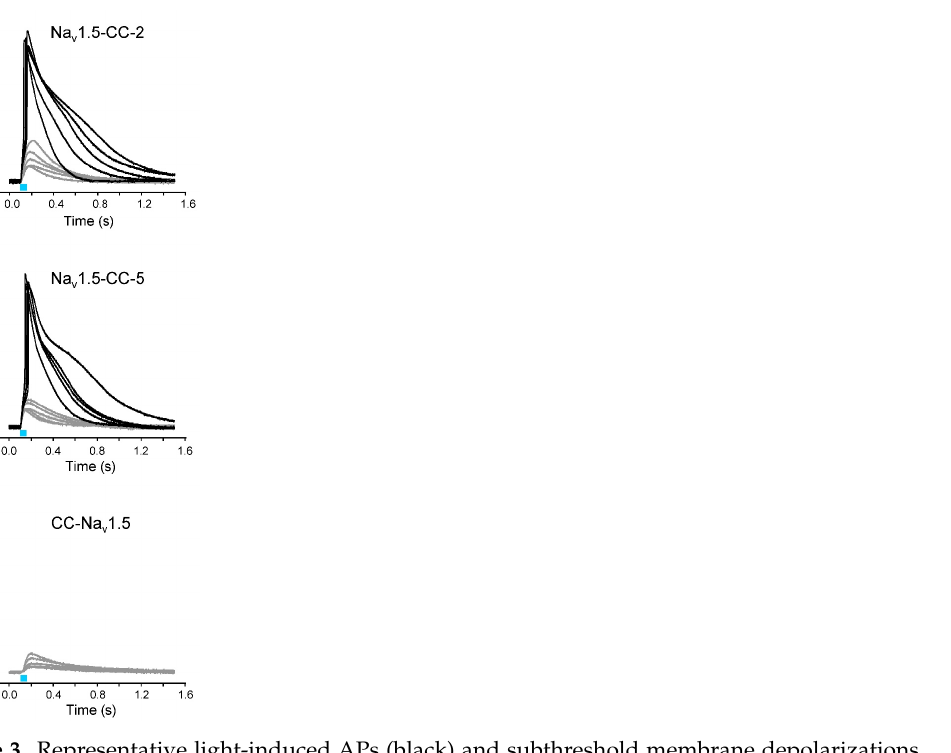
Figure 3. Representative light ‐ induced APs (black) and subthreshold membrane depolarizations (gray) in Xenopus oocytes expressing Na v 1.5 ‐ CC ‐ 2, Na v 1.5 ‐ CC ‐ 5, and CC ‐ Na v 1.5. The cRNA amount injected per oocyte was about 5 ng. The membrane potential was set to − 80 mV, and the change of the membrane voltage was followed in the current ‐ clamp mode upon a 50 ms blue ‐ light pulse (blue bar). The light flash was delivered simultaneously to each oocyte from two LEDs. For detailed sta ‐ tistics on AP parameters, see Table 3.